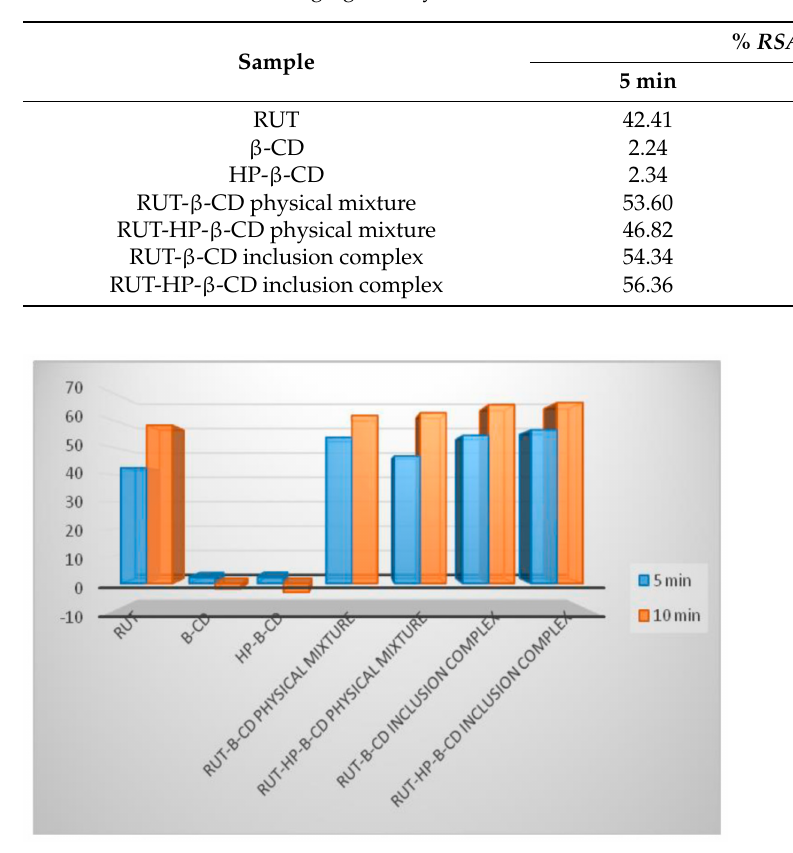
Figure 5. The evolution of ABTS radical